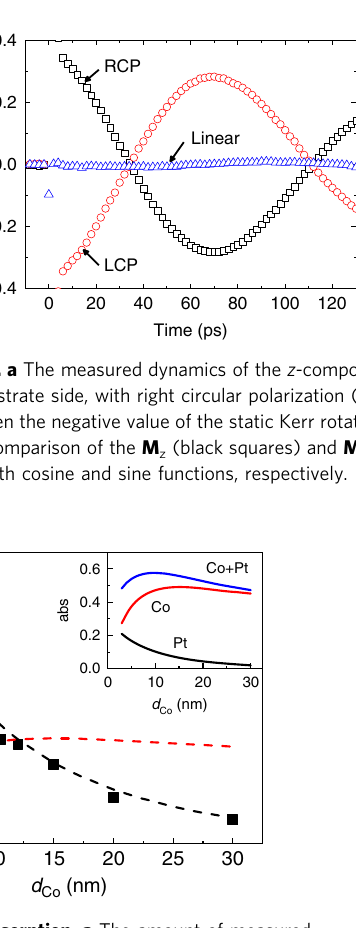
dominant over the fi eld-like torque M × σ that causes the initial tilting towards the ± y -direction.